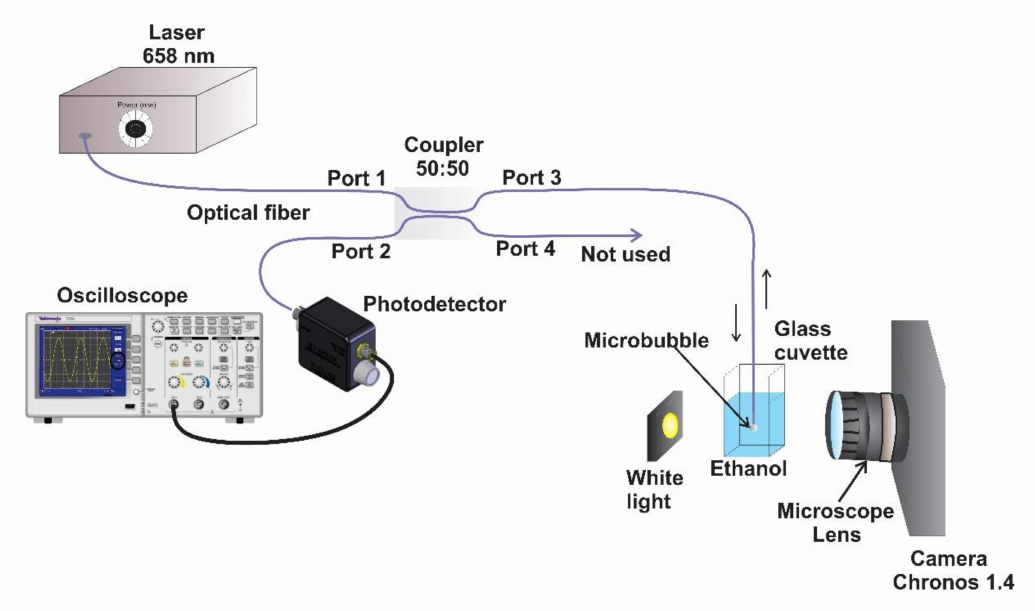
Figure 2. Experimental setup for immobilizing zinc nanoparticles on the tip of an optical fiber and for obtaining microbubble images and interference